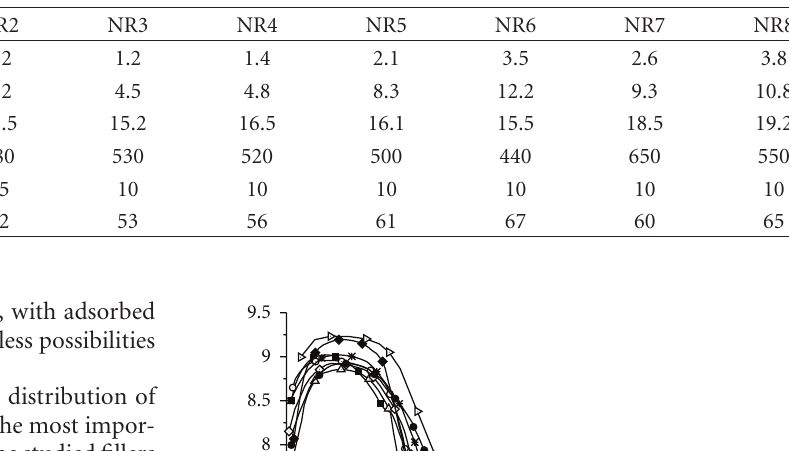
Table 4: Mechanical properties of the investigated vulcanizates.